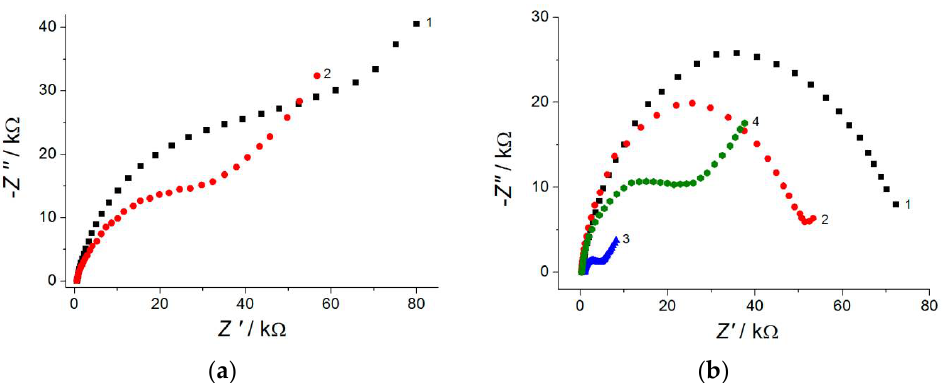
Figure 3. Electrochemical impedance spectra in the presence of 1.0 mM [Fe(CN) 6 ] 3−/4− in neutral medium for bare GCE (1) and the polymer-modified electrode: ( a ) poly(gallic acid)/MWCNTs/GCE (2); ( b ) poly(ellagic acid)/MWCNTs/GCE (2).